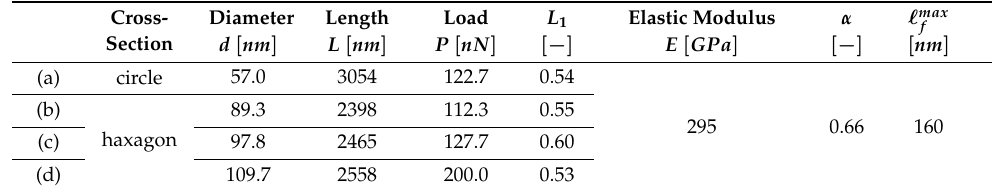
Figure 10. Circular and hexagonal cross sections used in bending test, and triangular (equilateral and isosceles) cross sections used in resonance test. Table 5. Beam dimensions, load position, and material parameters for GaN nanobeams in bending test [37] (see also Figure